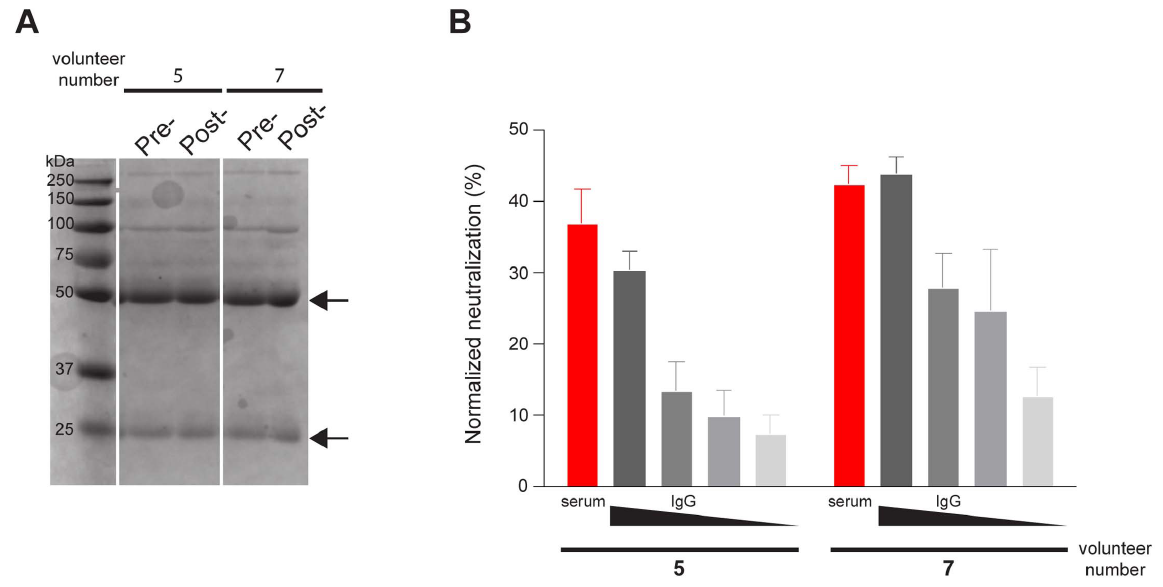
Figure 4. Neutralization of human antisera is mediated by immunoglobulin. Immunoglobulin was purified from volunteers’ pre- or post- vaccinated sera. (A) 3 m g total protein of purified immunoglobulin of volunteers 5 and 7 were separated by SDS-PAGE followed by coomassie staining for visualization. Heavy and light chains of purified immunoglobulin are marked with arrows. (B) The starting concentration of purified immunoglobulin was used at 1 in 5 (by volume) followed by three 3-fold dilutions (i.e. 1 in 15, 1 in 45 and 1 in 135) in the neutralization assay using chimeric 1a H77C/JFH-1 HCVcc (grey). The neutralization activities of the post- vaccinated samples were normalized against pre-vaccinated samples of the same individual at the indicated dilution. As comparison, the neutralization activity of sera using at 1 in 50 dilution is shown (red). During the purification, the recovered immunoglobulin were diluted 10 times in the procedure, therefore, 10 times more in volume of purified immunoglobulin (1 in 5 dilution) was used compared with sera (1 in 50 dilution) (see materials and